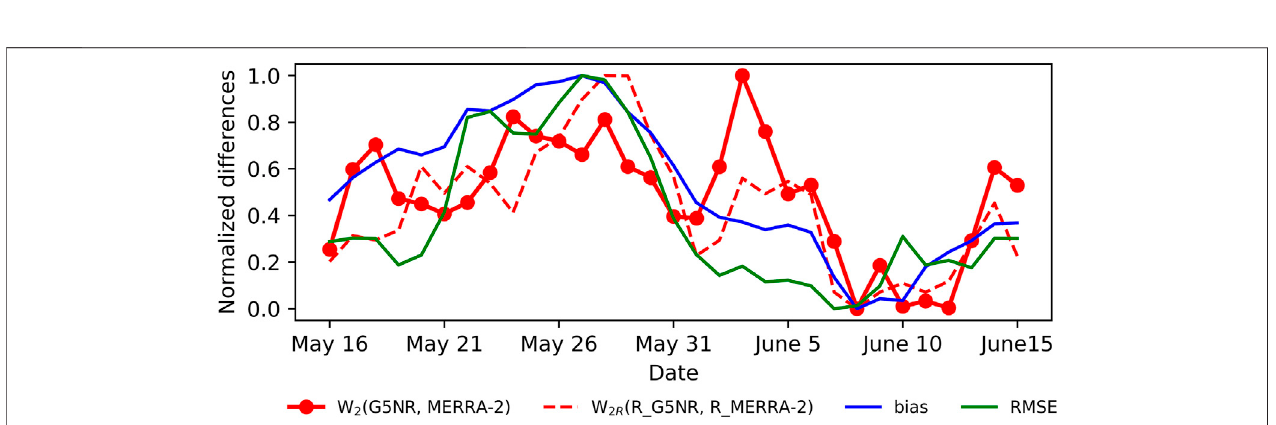
FIGURE 3| The red solid line represents normalized W 2 between daily AOD maps from G5NR and MERRA-2. Normalized W 2 R (red dashed line), biases (blue sold line), and RMSEs (green solid line) were calculated between R_G5NR and R_MERRA-2 daily AODs from May 16th, 2006 to June 15th, 2006.